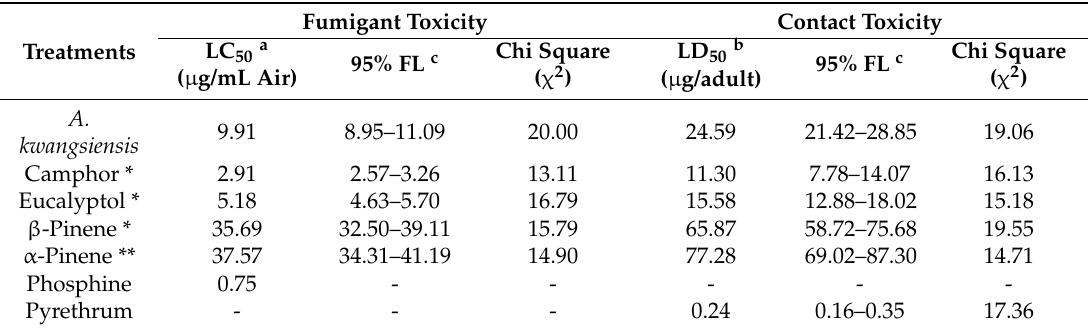
Table 2. Fumigant and contact toxicity of essential oil of A. kwangsiensis aerial parts and its main components against Lasioderma serricorne